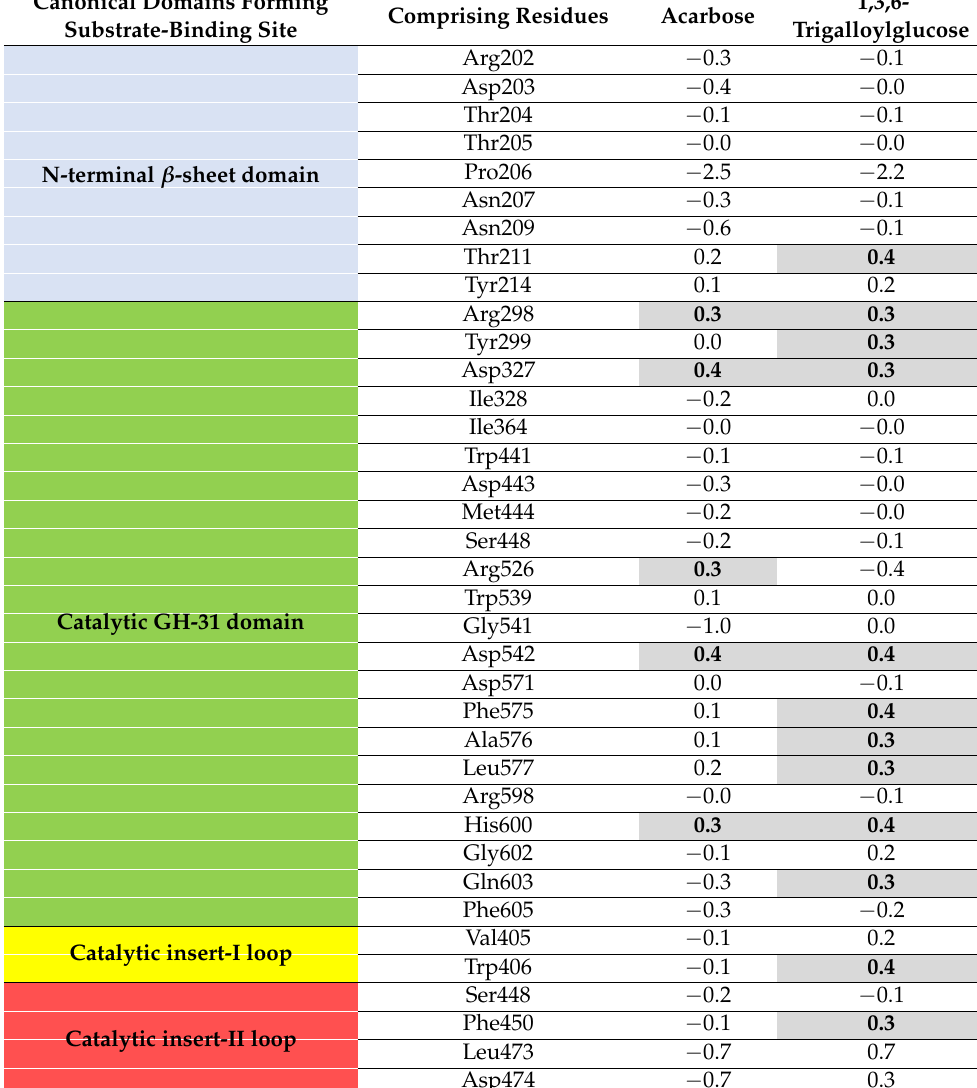
Table 2. Estimated ∆ RMSF a values [Å] for ligand-hMGAM proteins along 200 ns MD simulation. Canonical Domains Forming Substrate-Binding